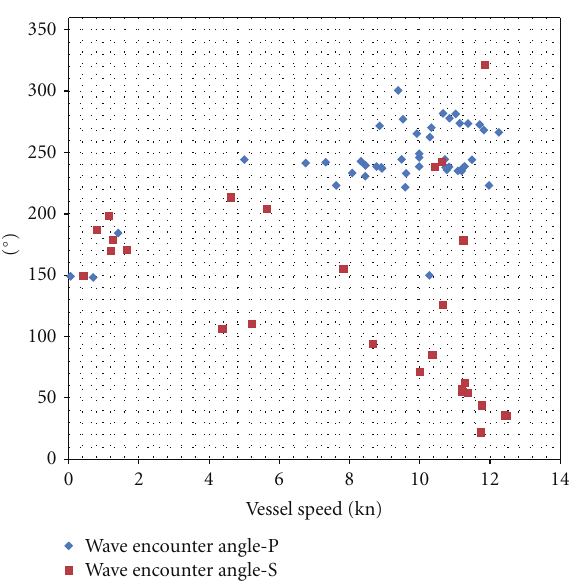
Figure 34: Wave encounter angle against ship speed—port unit (blue) and starboard unit